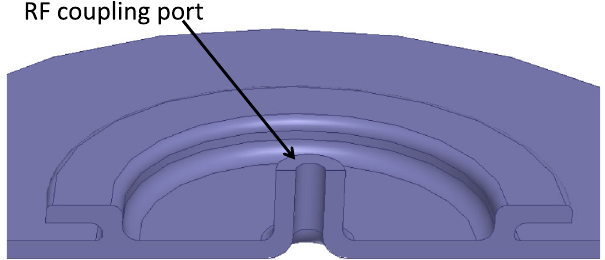
FIG. 7. Structures to test the reflection at choke.